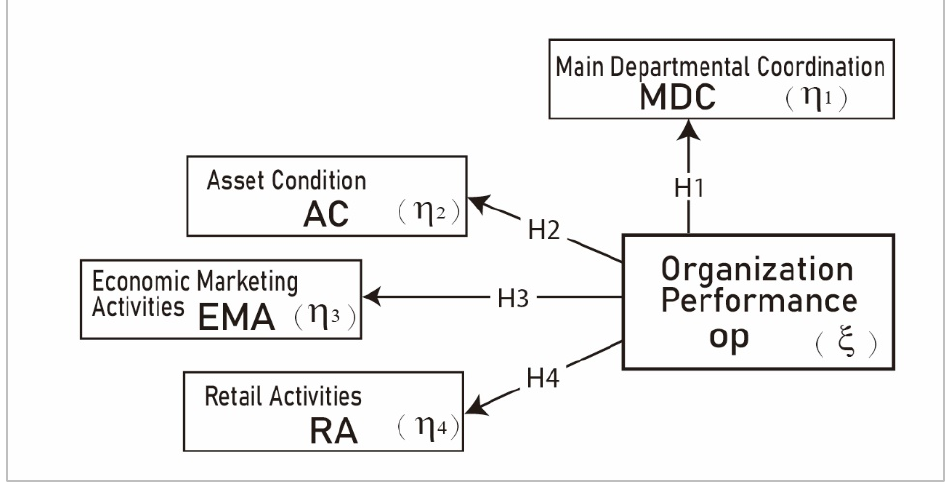
Figure 1. Constructs of main dimensions of LTFA. Source: this study.